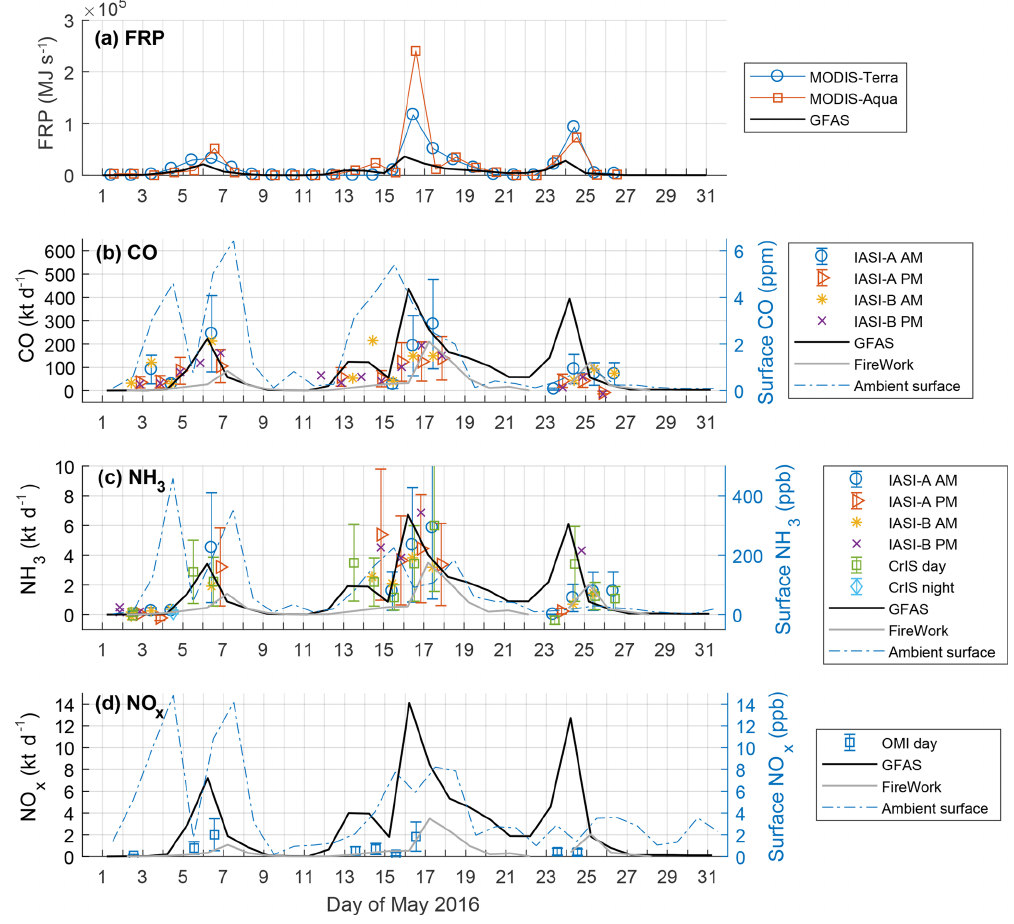
Figure 8. Time series of (a) FRP and emission estimates and surface concentrations for (b) CO, (c) NH 3 , and (d) NO x from satellite, models, and air monitoring stations. Note that error bars are not shown for IASI-B emissions to improve the readability of the figure. The surface concentrations are the 24h average concentrations of CO at the Fort McMurray–Athabasca Valley air monitoring station and NH 3 and NO x at the Fort McMurray–Patricia McInnes air monitoring station. Note that NO x measured at Fort McMurray–Athabasca Valley shows similar variability, but is not shown